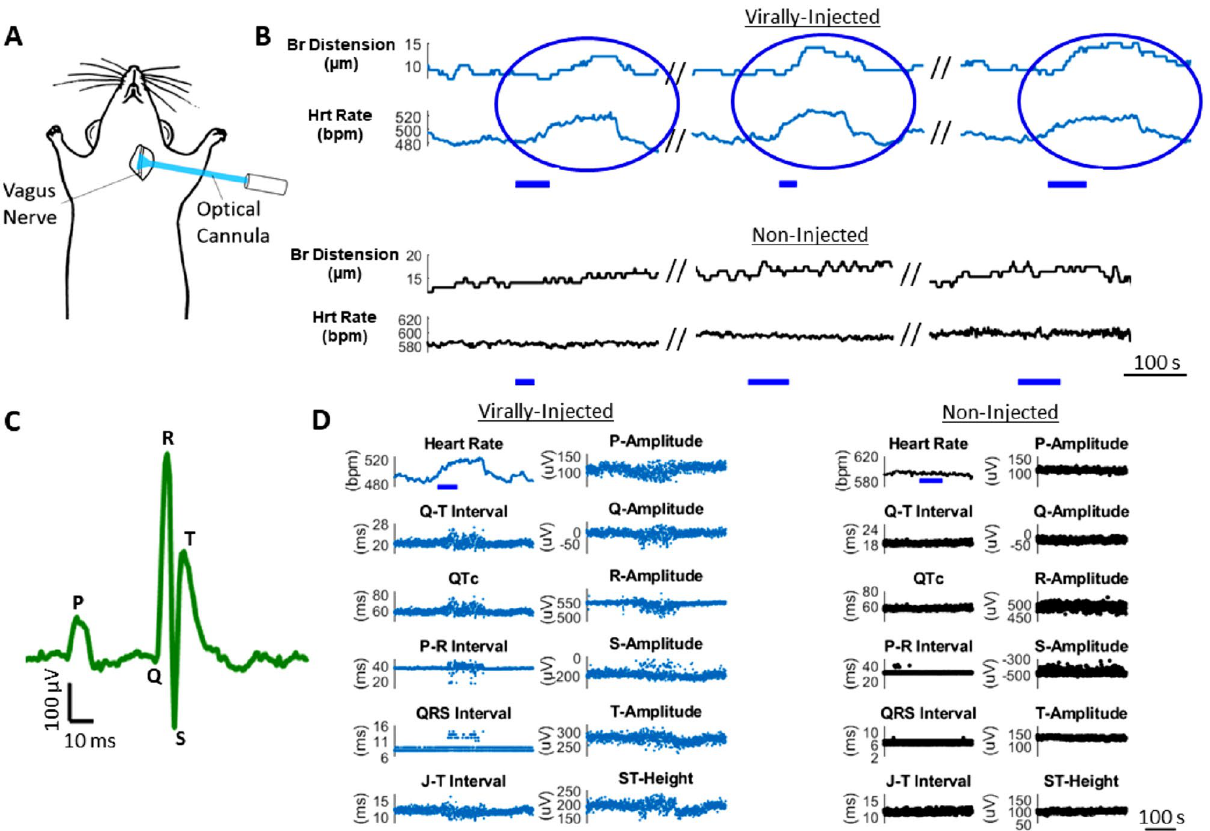
Figure 4. 1-Photon stimulation of the cervical vagus nerve perturbs vitals and ECG parameters. ( A ) Schematic of photostimulation in the anesthetized mouse. The left vagus nerve is exposed and illuminated with a 473 nm laser, delivered through an optical fiber/cannula. ( B ) Three consecutive photostimuli (blue bar) cause increases in heart rate and breath distension in a virally-injected (AAVrg-Syn-Chronos-eGFP) mouse while no changes occur in the non-injected control mouse. Note that the vertical axes in panels B and D show a limited range of values. ( C ) Representative ECG waveform (average of 4 beats). ( D ) Waveform parameters are modulated following stimulus onset through the duration of heart rate excursion in the virally-injected mouse while parameters are unmodulated in non-injected controls. (Blue bar: 473 nm, 5 ms pulses, 20 Hz, 10mW unmodulated